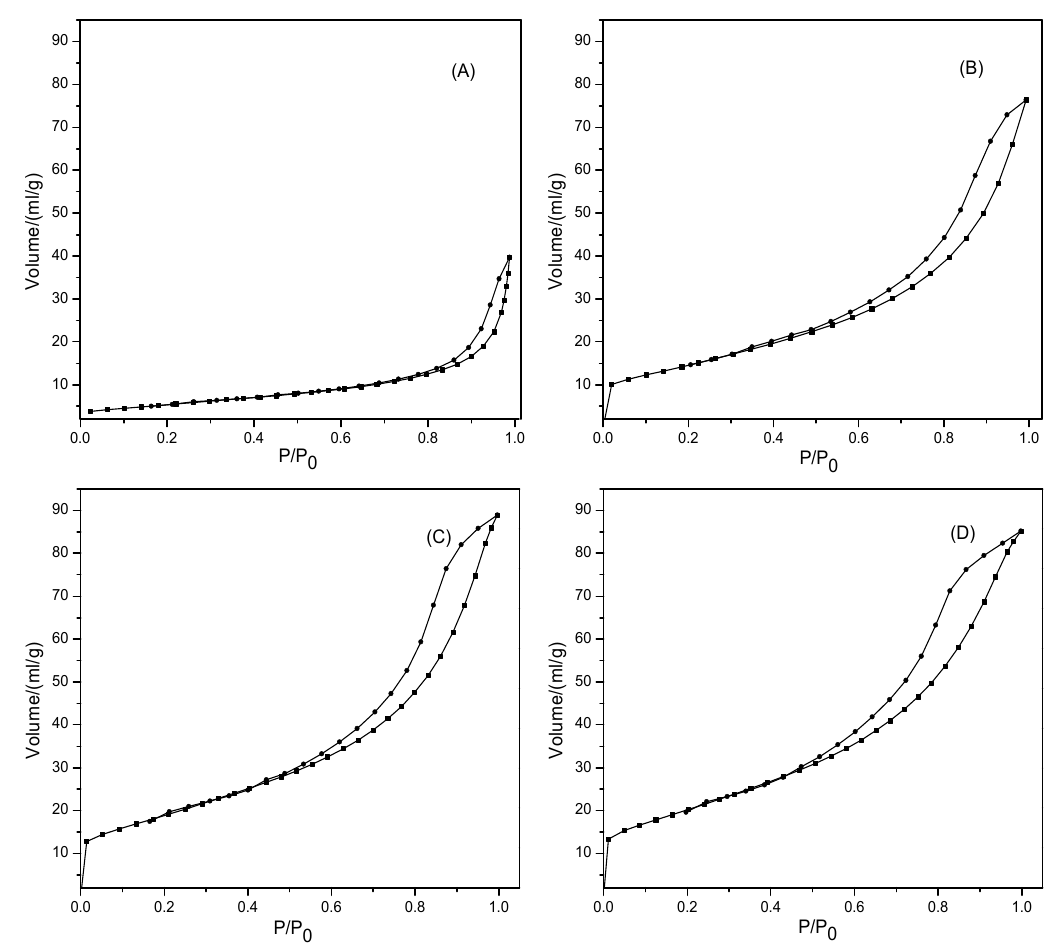
Figure 4. N 2 adsorption–desorption isotherms for catalysts of ( A ) Co 3 O 4 ; ( B ) Co 3 O 4 -CeO 2 ; ( C ) Co 3 O 4 -CeO 2 -0.5; and ( D ) Co 3 O 4 ‐ CeO 2 ‐ 1.0.